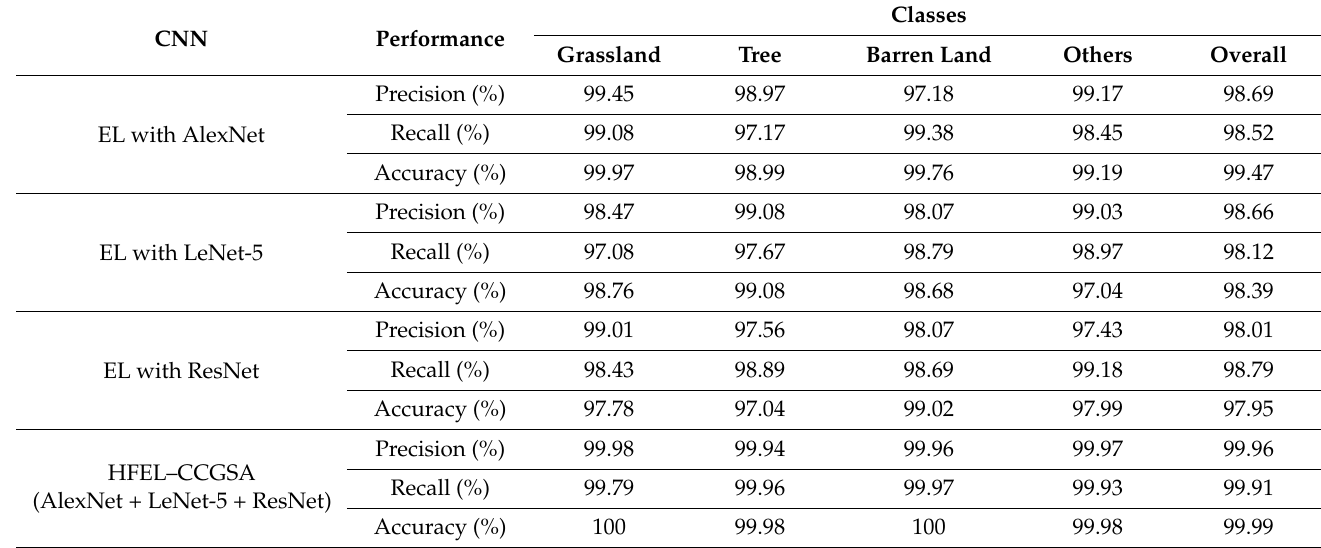
Table 2. Performance analysis for individual CNN and HFEL–CCGSA (AlexNet + LeNet-5 + ResNet) on SAT-4 dataset. CNN